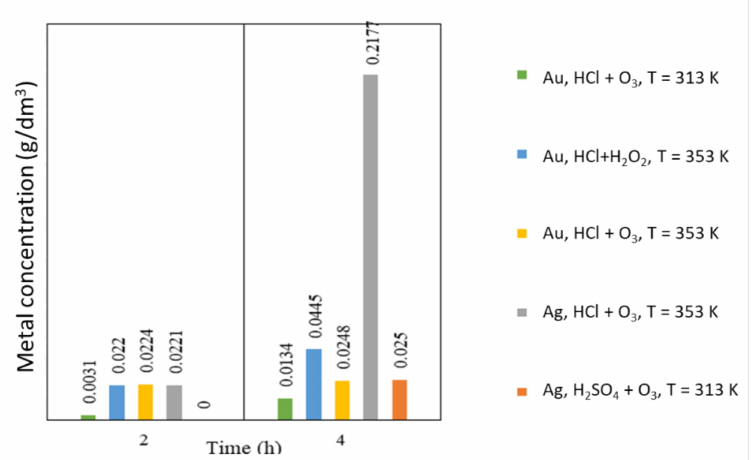
Figure 5. Gold and silver concentrations obtained after leaching in HCl and H 2 SO 4 with the addition of H 2 O 2 or O 3 during 2 h and 4